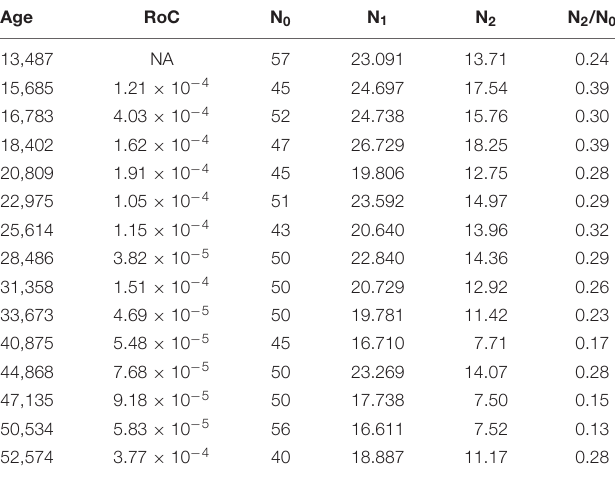
TABLE 4 | Ecological metrics of Laguna Pindo glacial vegetation based on pollen data: rates of change (RoC) were calculated following Urrego et al. (2009),